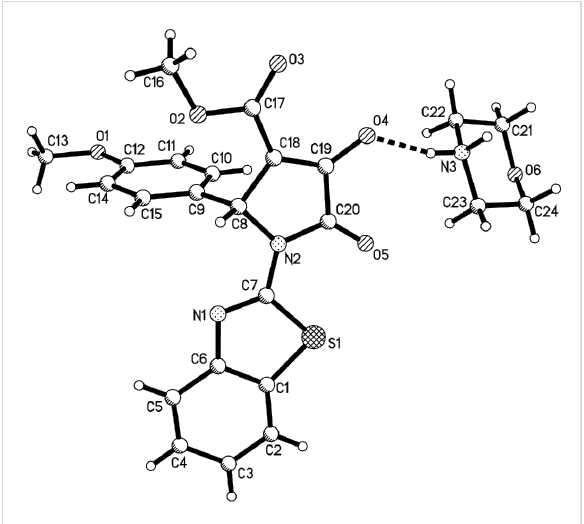
Figure 2: Molecular structure of compound 2a .